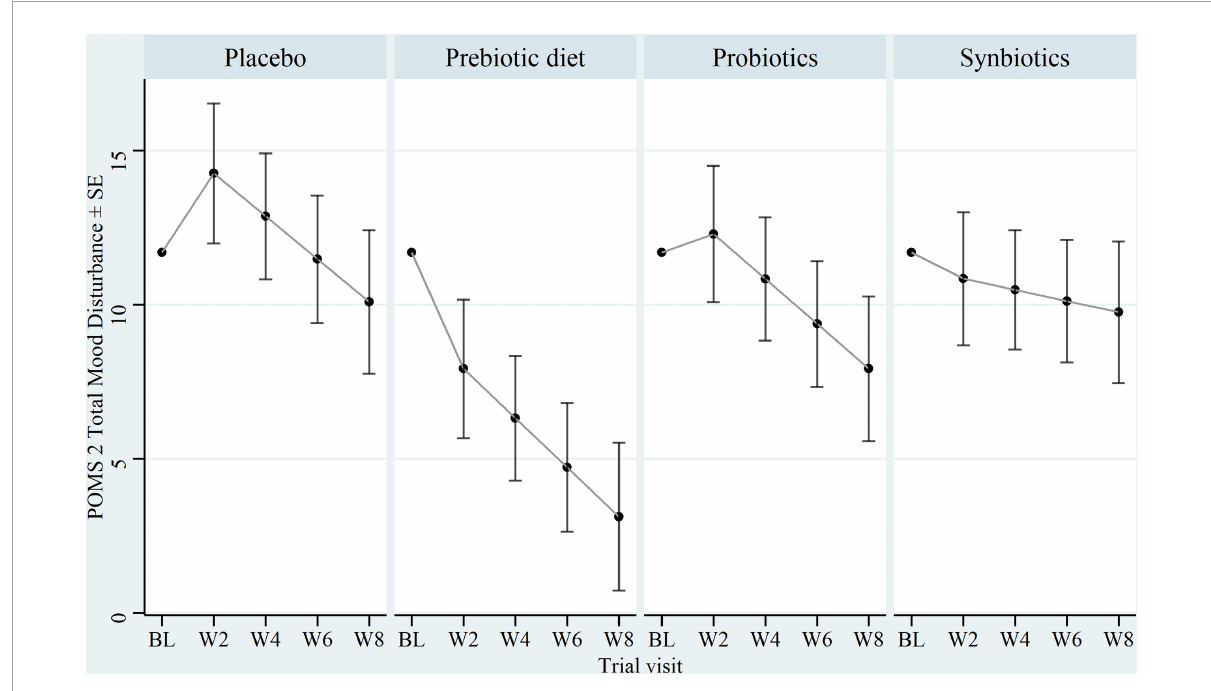
FIGURE2 Baseline and estimated follow-up POMS 2-SF total mood disturbance (TMD) score by treatment. Non-factorial model-based estimates of POMS-2 TMD at each visit by group. Model-based predictions are calculated with baseline TMD score at its mean. POMS 2, Profile of Mood States 2-SF; SE, standard error; BL, week 0; W2, week 2; W4, week 4; W6, week 6, W8, week 8.